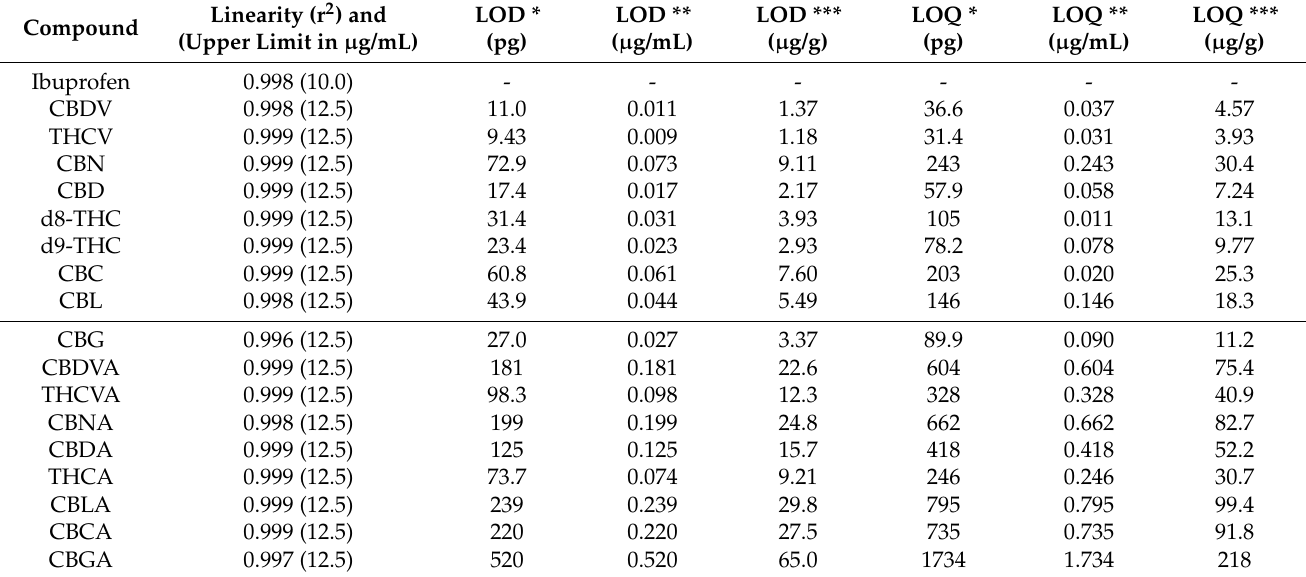
Table 2. Linearity, and detection and quantification limits for 17 cannabinoids and